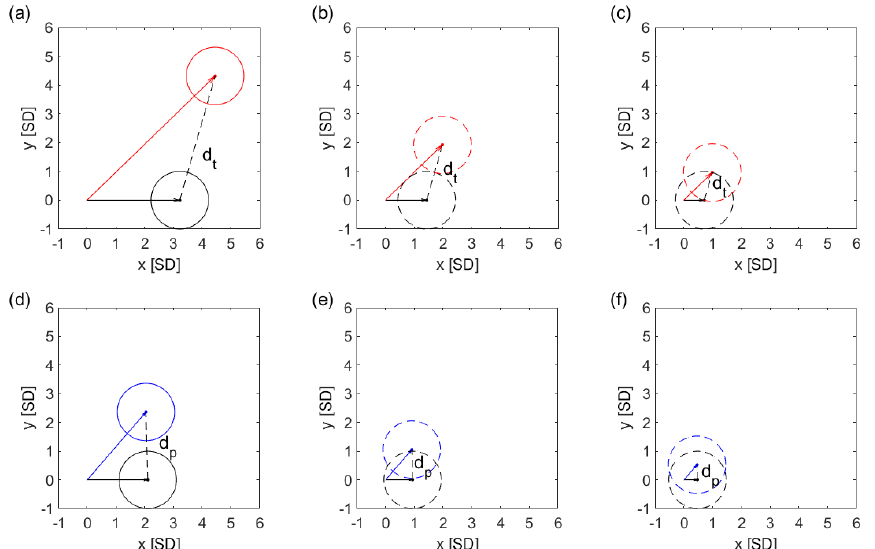
Figure 11. Panels (a) – (c) are detectability plots for the difference in temperature responses between GLENS (black) and EQ (red) at three different levels of cooling: (a) 4 ◦ C, (b) 1.8 ◦ C, and (c) 0.9 ◦ C. Panels (d) – (f) are detectability plots for the difference in precipitation re- sponses between GLENS (black) and EQ (red) at those three levels of cooling. Dots represent the estimated mean temperature or precipitation responses for the corresponding levels of cooling. Temperature and precipitation responses are expressed in the number of SDs of 20-year averages of temperature and precipitation respectively. In each plot, both the x and y axes are distances in the number of standard deviations. As the cooling level decreases, less area on the Earth has detectably different climate responses, and the ability to detect the difference between GLENS and EQ decreases.